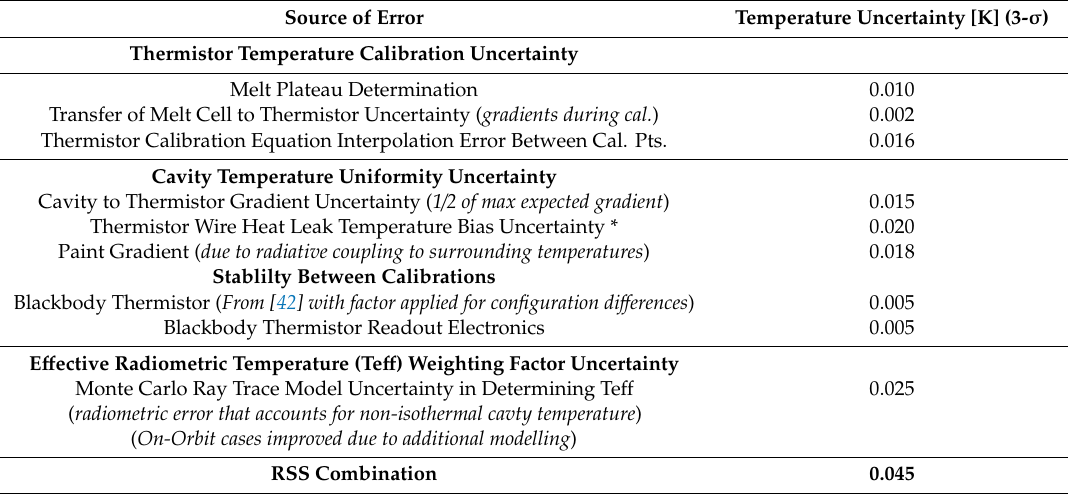
Table 6. OARS temperature uncertainty budget. Refer to Siwek et al. [42] for further details on the thermistor stability.